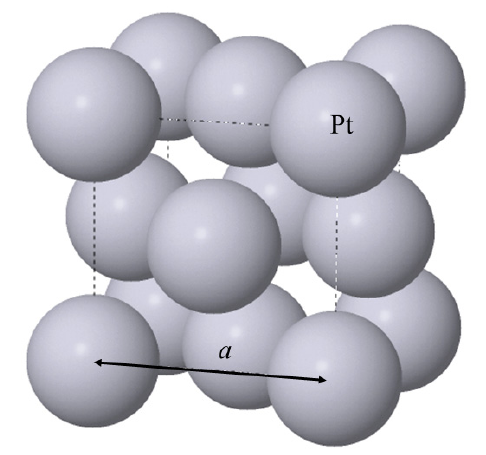
Figure 1. Orthogonal unit cell of the face-centred cubic (FCC) bulk Pt. The lattice parameter a is indicated by the solid arrow. The dashed lines are the edges of the orthogonal unit cell.